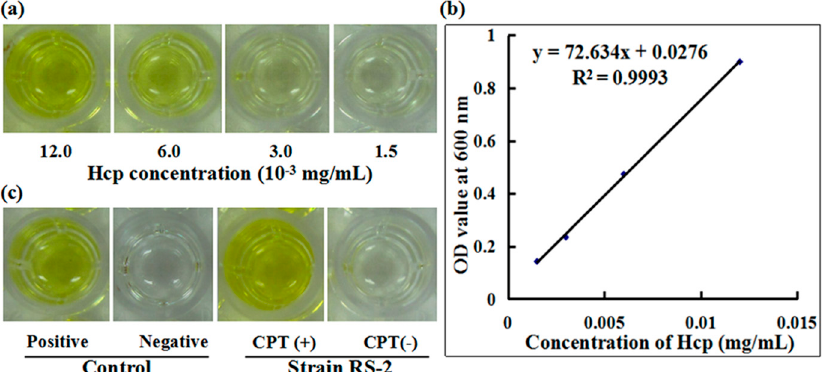
Figure 7. Effect of CPT on the secretion of Hcp protein. ( a ) ELISA of Hcp protein at different concentrations; ( b ) Standard curve; ( c ) ELISA measurement of Hcp secreted by CPT.